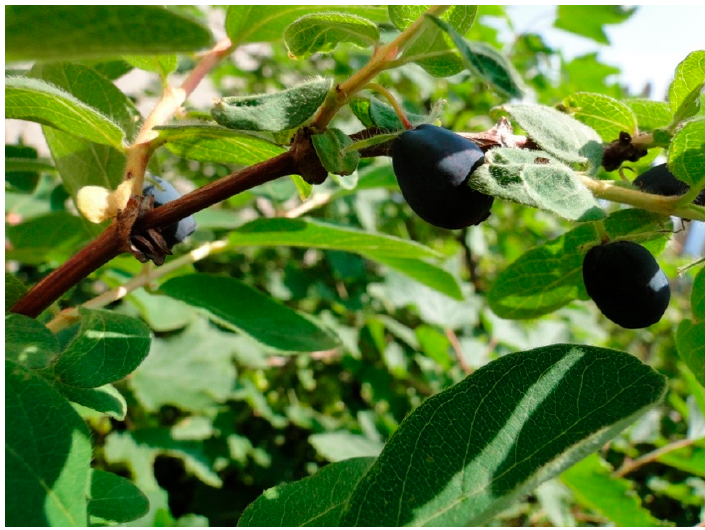
Figure 1. Lonicera caerulea L. with fruit.